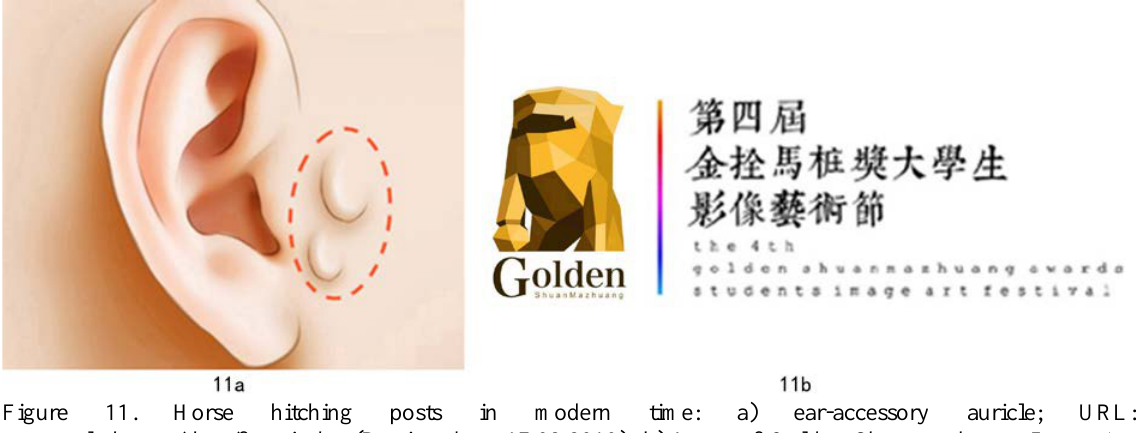
Figure 11. Horse hitching posts in modern time: a) ear-accessory auricle; URL: www.zylmk.com/ebzx/fuerqiechu (Retrieved on 17.03.2019), b) Logo of Golden Shuanmazhuang Image Art Festival. Photo from internet. URL: http://gou.hsw.cn/system/2015/0706/2963.shtml (Retrieved on